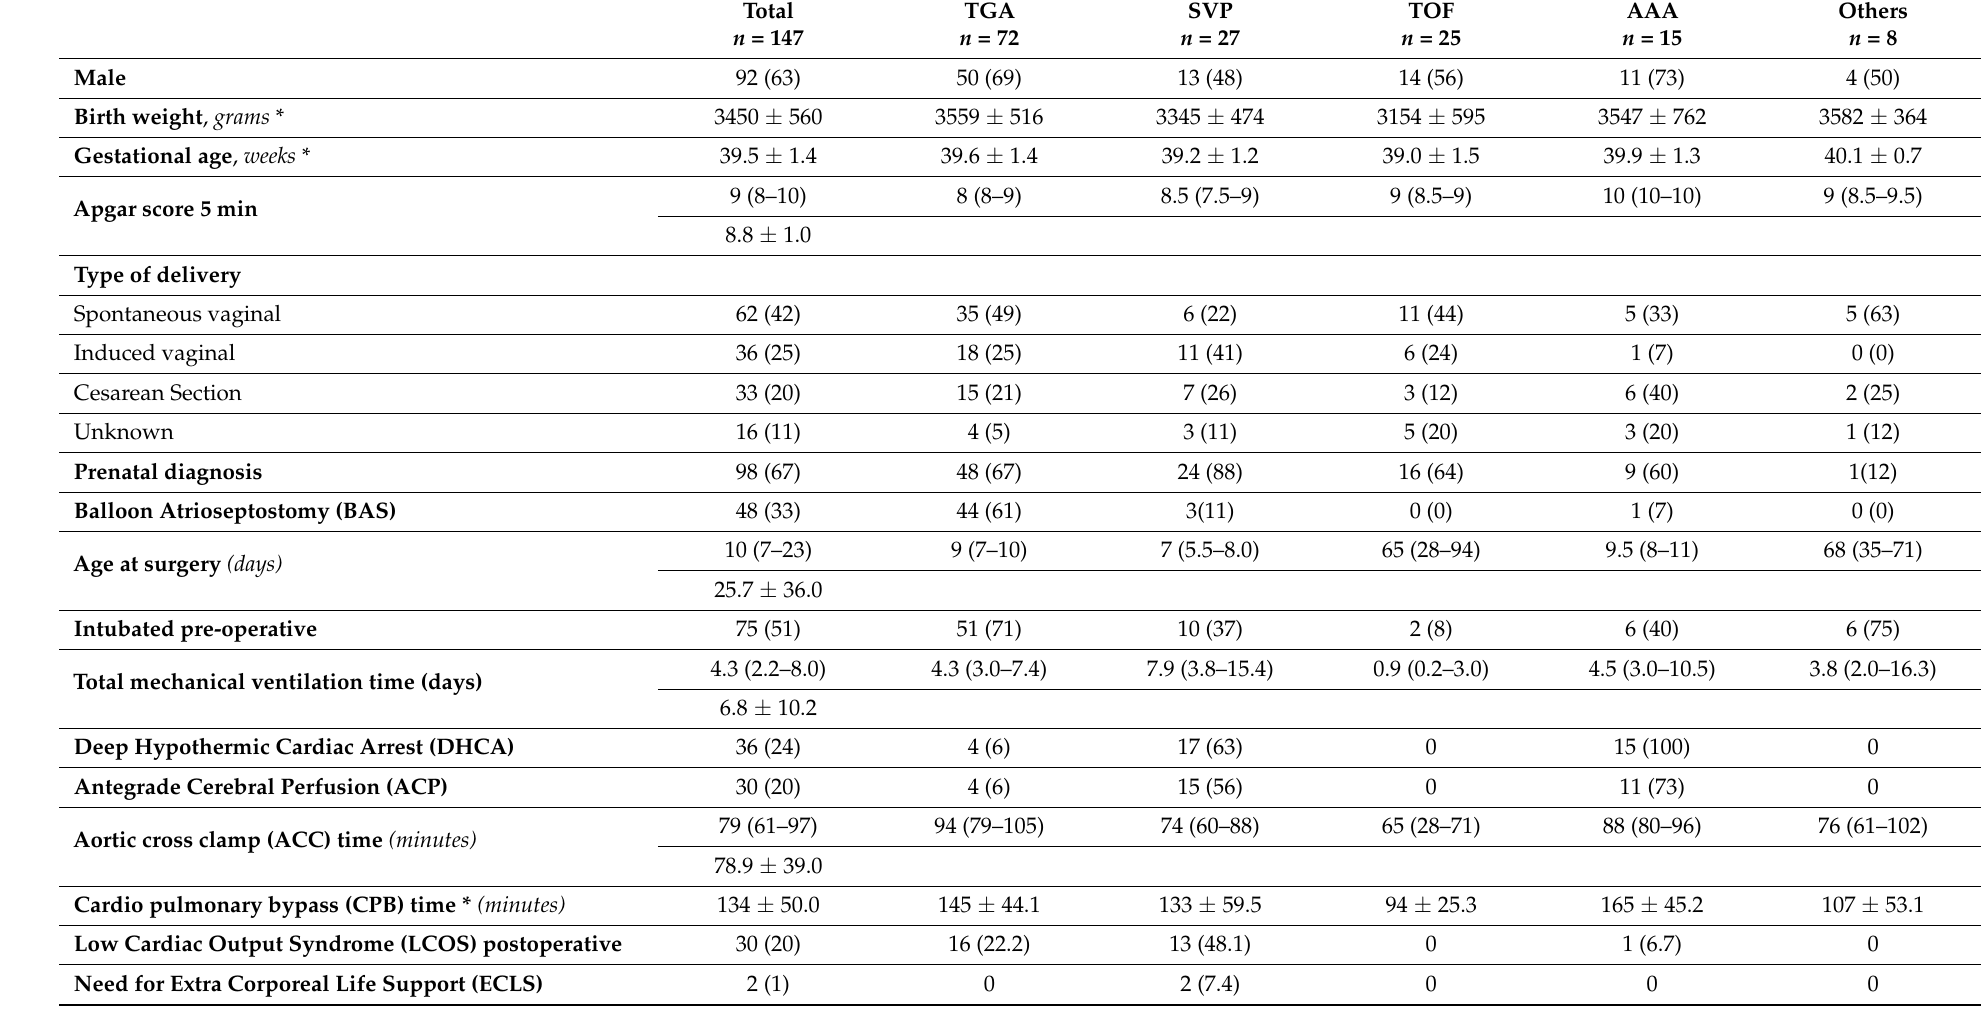
Table 1. Patient